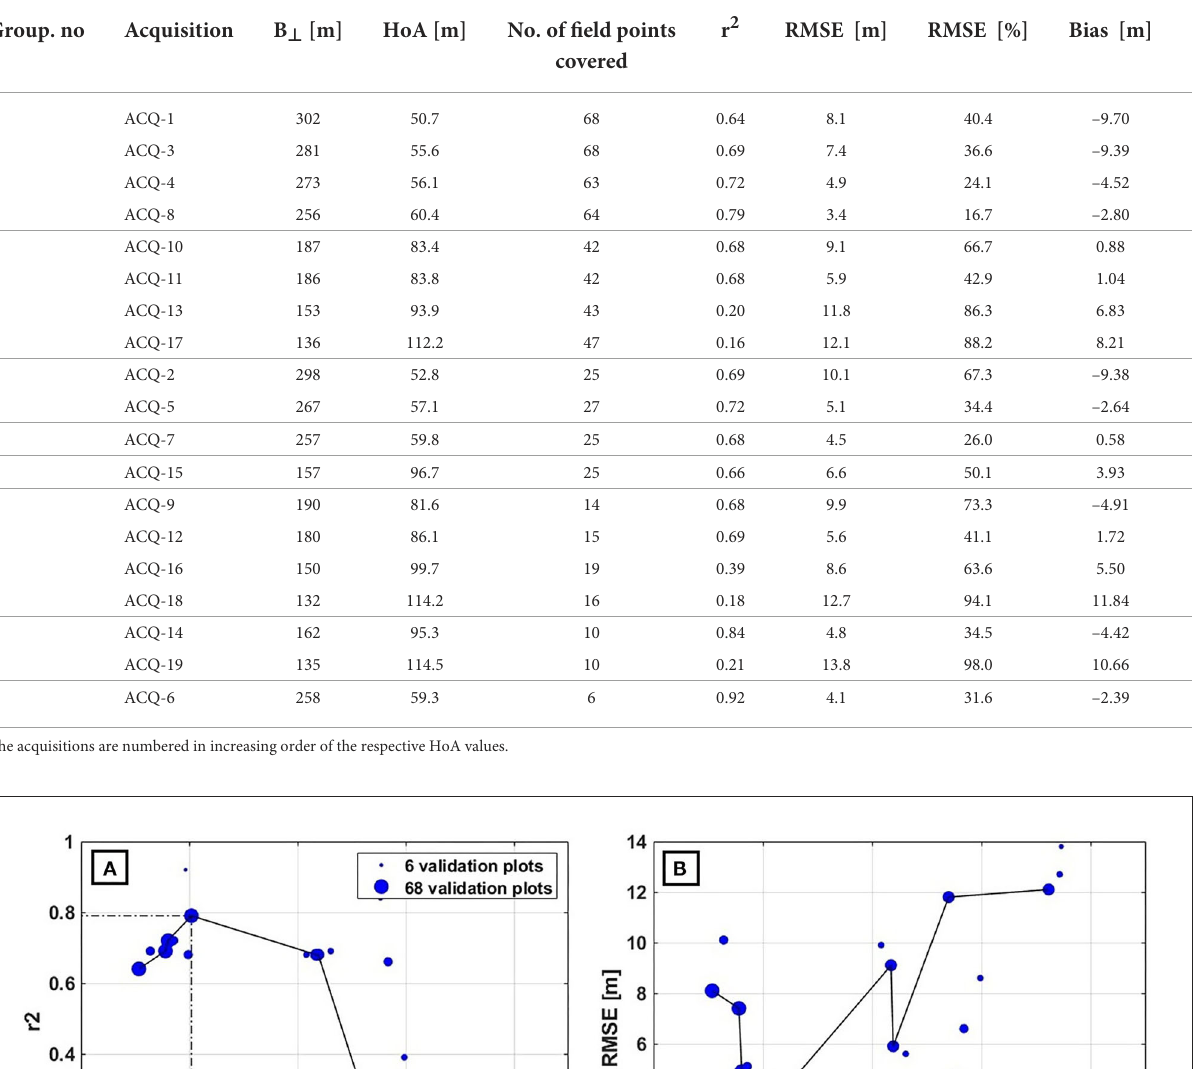
TABLE 3 Validation of PolInSAR estimated heights of all TDX datasets.